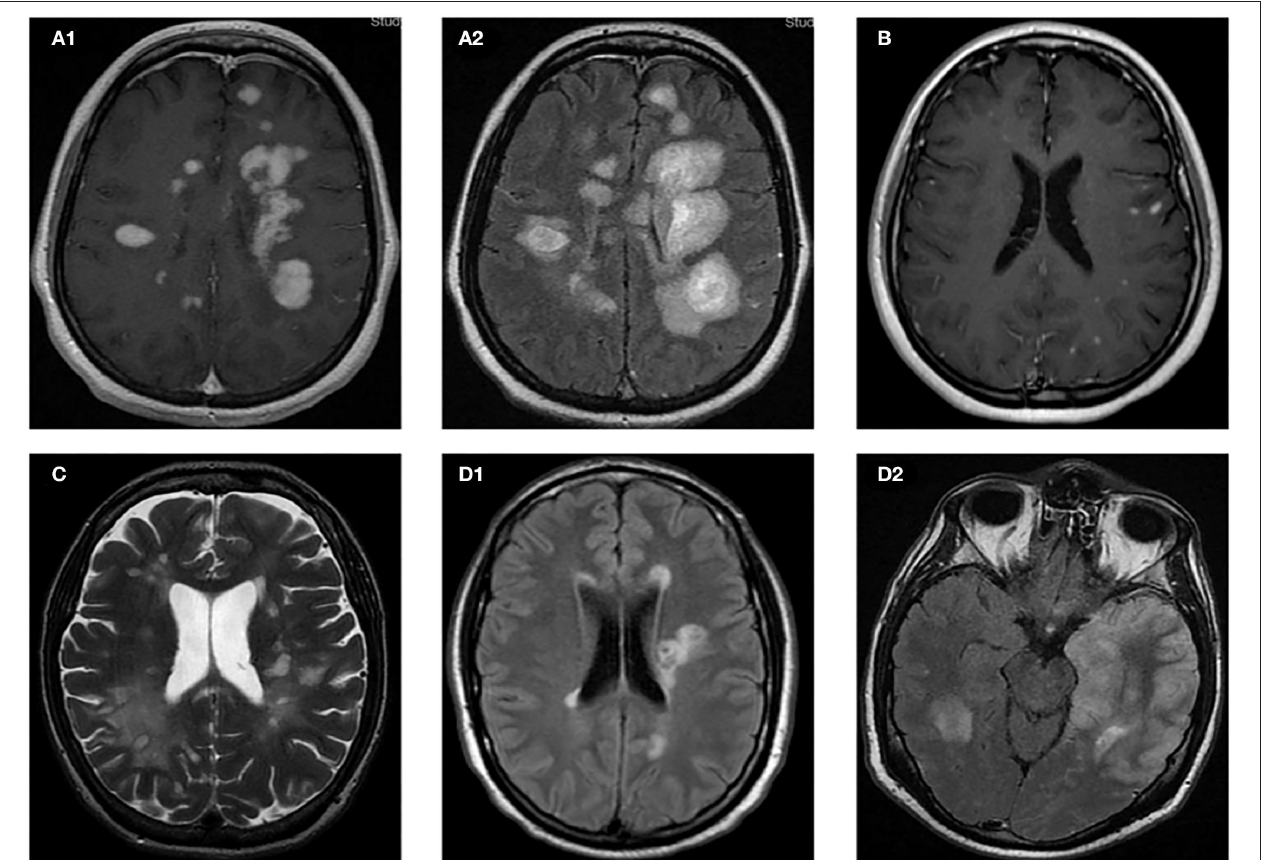
FIGURE 1 | Brain MRI of the cases. (A) Case 1: axial T1 post-gadolinium sequence (A1) and FLAIR sequence (A2) . (B) Case 2: axial T1 post-gadolinium sequence. (C) Case 3: axial T2 sequence. (D) Case 4: axial FLAIR sequence on day − 1 (D1) and on day + 21 (D2) with respect to vaccination.